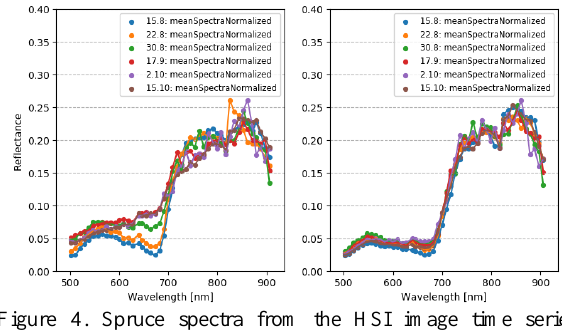
Figure 4. Spruce spectra from the HSI image time series (normalized mean spectra). The dying spruce is shown on left and the healthy spruce on